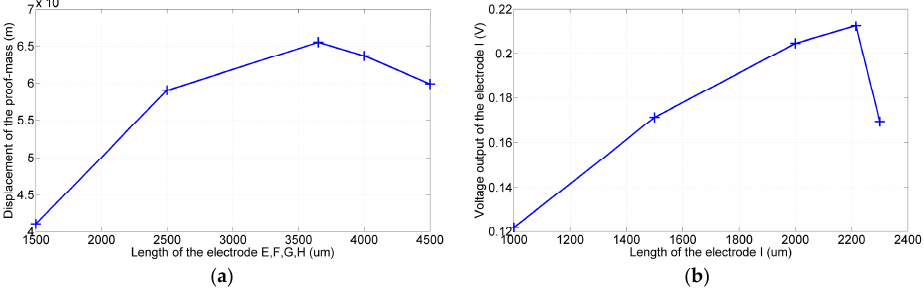
Figure 5. Simulation results: ( a ) Displacement of the proof mass varied with the lengths of electrodes ( E , F , G , H ). The optimal length was 3650 μ m for all electrodes. ( b ) Voltage output of electrodes ( I , J , K , L ) varied with their lengths. The optimal lengths was 2215 μ m for all electrodes.